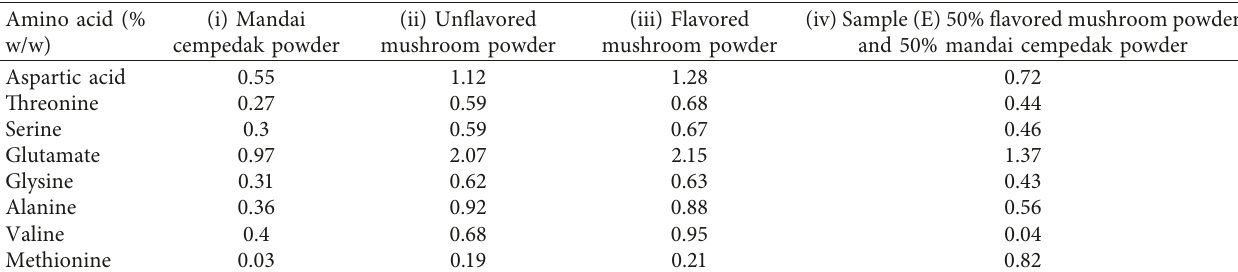
Table 5: Amino acid composition of flavored mushroom powder and mandai cempedak powder.